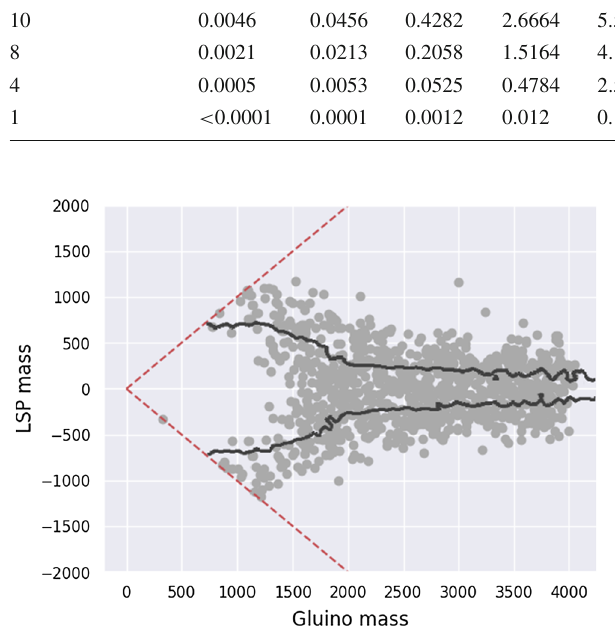
Fig. 7 The model points that were selected in a pool-based sampling projected on the gluino mass ( m ˜ g ) – LSP mass ( m ˜ χ 0 ) plane. The algo- 1 rithm did not have direct access to the variables on the axes, but was nevertheless able to sample points in the region around the decision boundary, indicated by the solid black line in the figure. The dashed red linesindicatetheboundaryofthemodel,outsideofwhichnodatapoints will be sampled (caused by the fact that no supersymmetric particle can be lighter than the